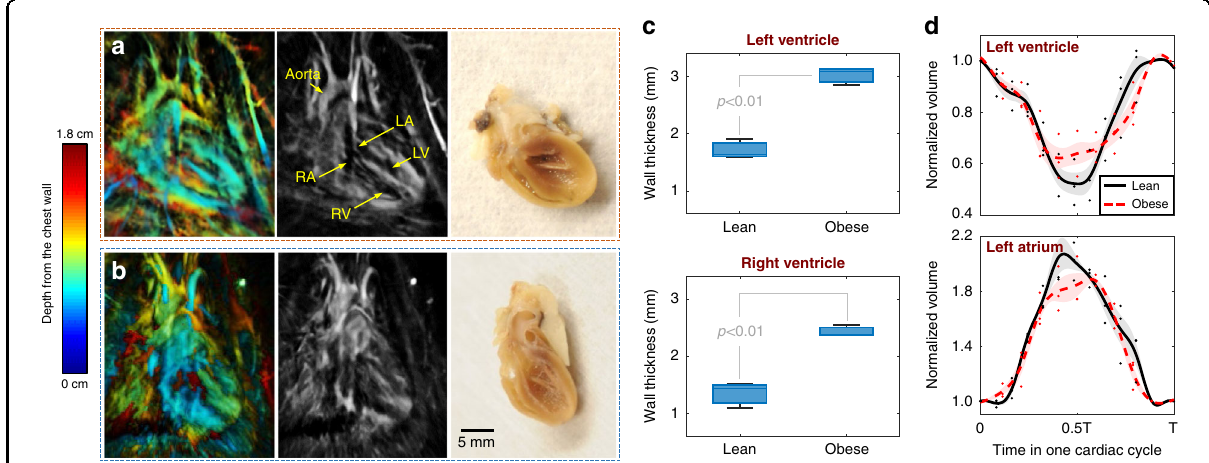
Fig. 3 Differences in cardiac anatomy and function between the Zucker obese and lean rats. a Cardiac anatomy of a Zucker obese rat. Left panel: Color-encoded depth-resolved image of the heart; middle panel: Cross-sectional image of the heart; Right: Longitudinal sectioning of the corresponding hypertrophic heart. LA, left atrium; LV, left ventricle; RA, right atrium; RV, right ventricle. b Cardiac anatomy of a Zucker lean rat (control group). c Free wall thickness measurements of the left ventricle (top: p < 0.01, n = 3) and right ventricle (bottom: p < 0.01, n = 3) between the obese and lean rats. d Relative volume variations of the left ventricles and atriums between the obese and lean rats. The shadow behind curves represents the standard deviation across multiple rats ( n =